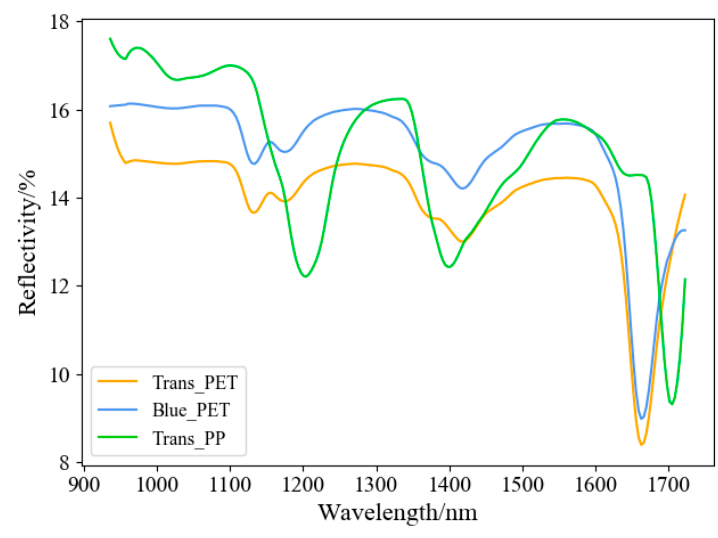
Figure 6. Mean spectral curve of waste plastic bottles.